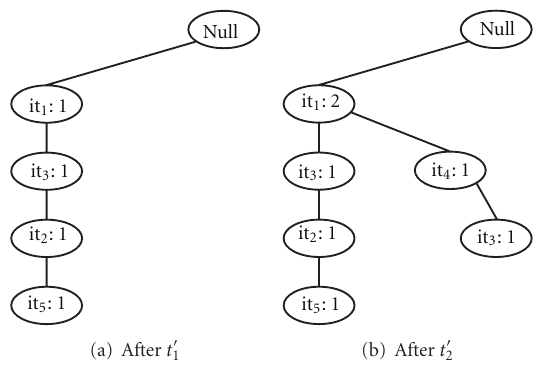
Figure 1: Refined FP tree (1).